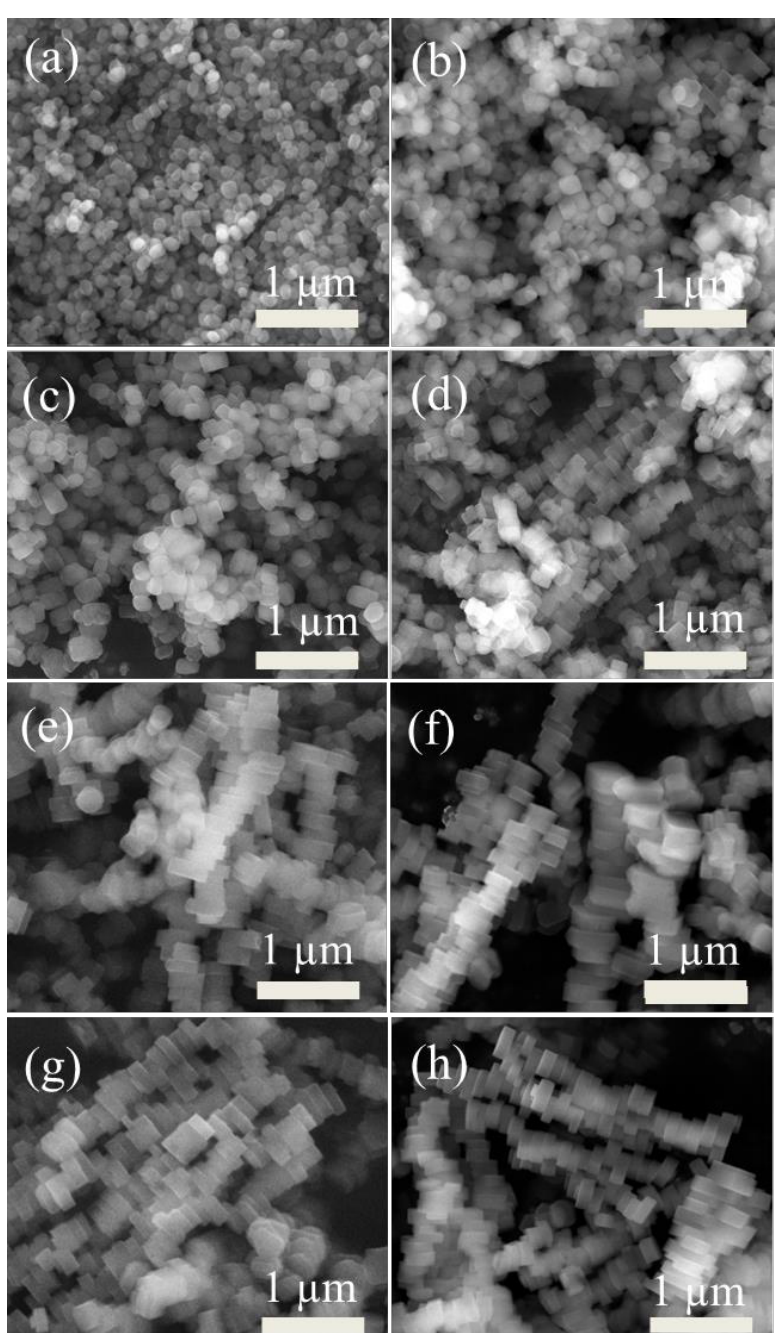
Figure 3. SEM images of ZSM5 zeolite prepared with different ethanol concentrations. ( a ) ZSM5-0; ( b ) ZSM5-1; ( c ) ZSM5-2; ( d ) ZSM5-4; ( e ) ZSM5-5; ( f ) ZSM5-6; ( g ) ZSM5-7; ( h ) ZSM5-8.